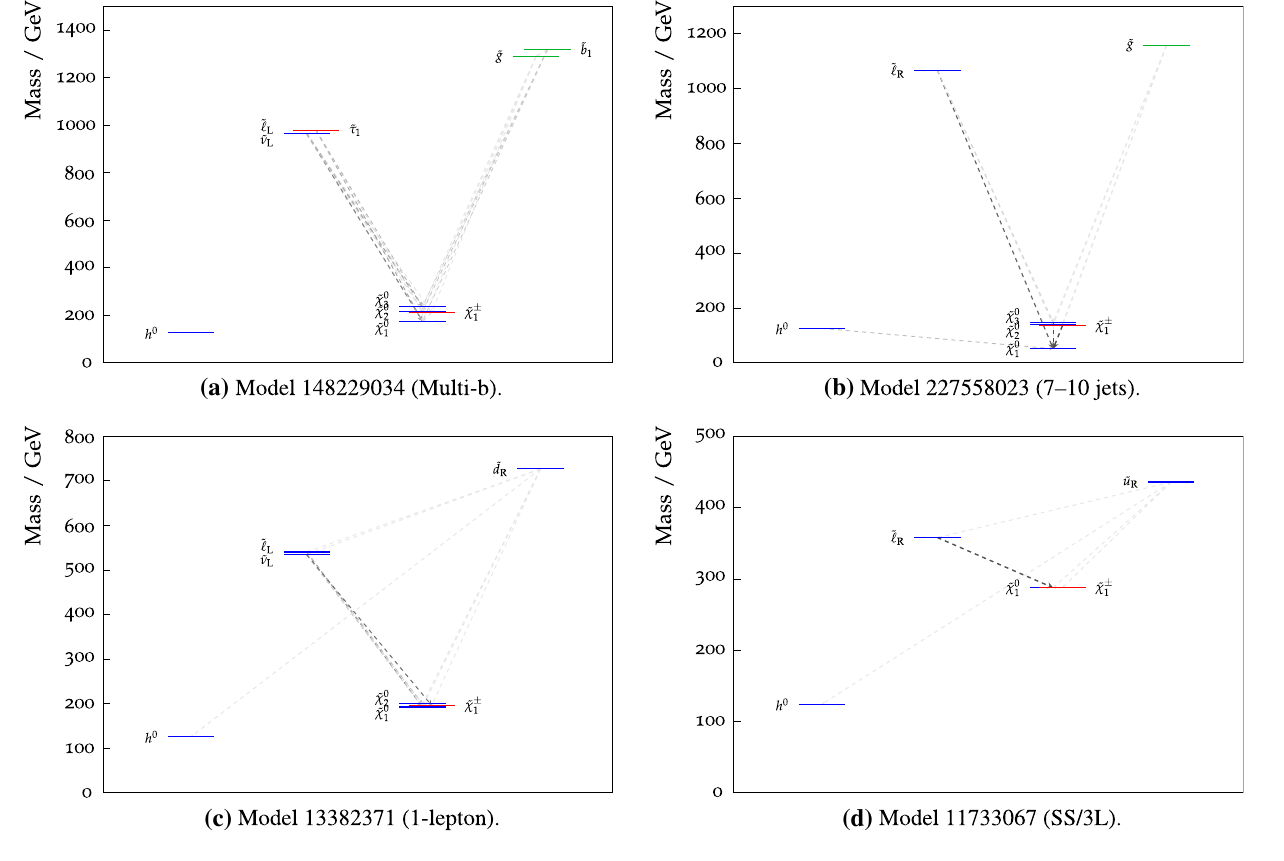
Fig. 4 Representative mass spectra produced using PySLHA [105] with model number in the captions for excluded points where the cor- responding analysis in parentheses had greatest sensitivity. These show the most relevant low-mass sparticles and their decays; for the full mass spectra, see Fig. 15 in Appendix C. The grey arrows show the branch- ing ratios between two sparticles and proportional to its brightness. The model displayed for the 7–10 jets analysis is the one with the lightest